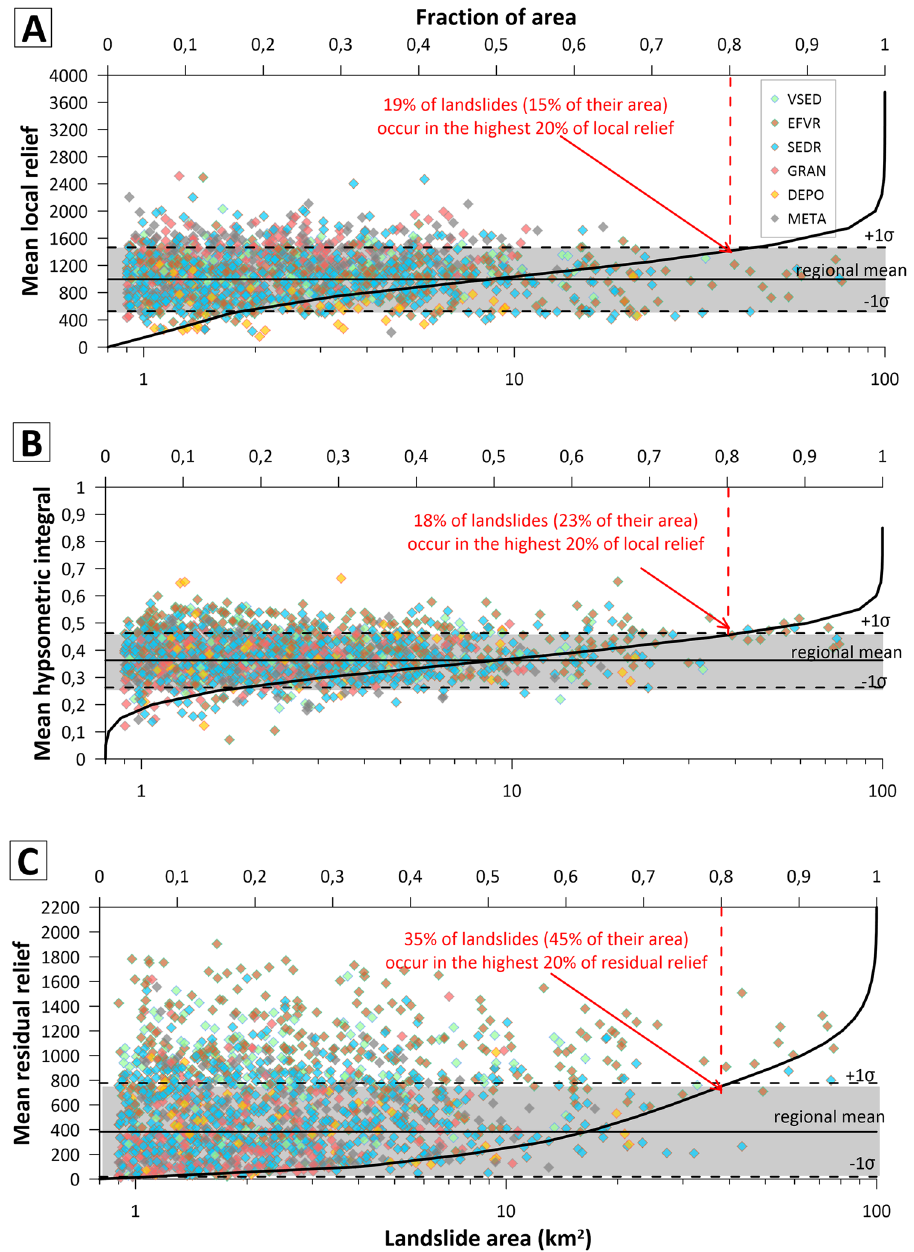
Figure 2. Relationship between large landslide areas and ( A ) local relief, ( B ) hypsometric integral and ( C ) residual relief calculated as mean values within 5-km buffers around landslide centroids. Landslides are stratified according to their dominant lithology (see Fig. 1A for an explanation of the abbreviations.). Black curves are cumulative distributions of local relief, hypsometric integral and residual relief respectively within the PIS